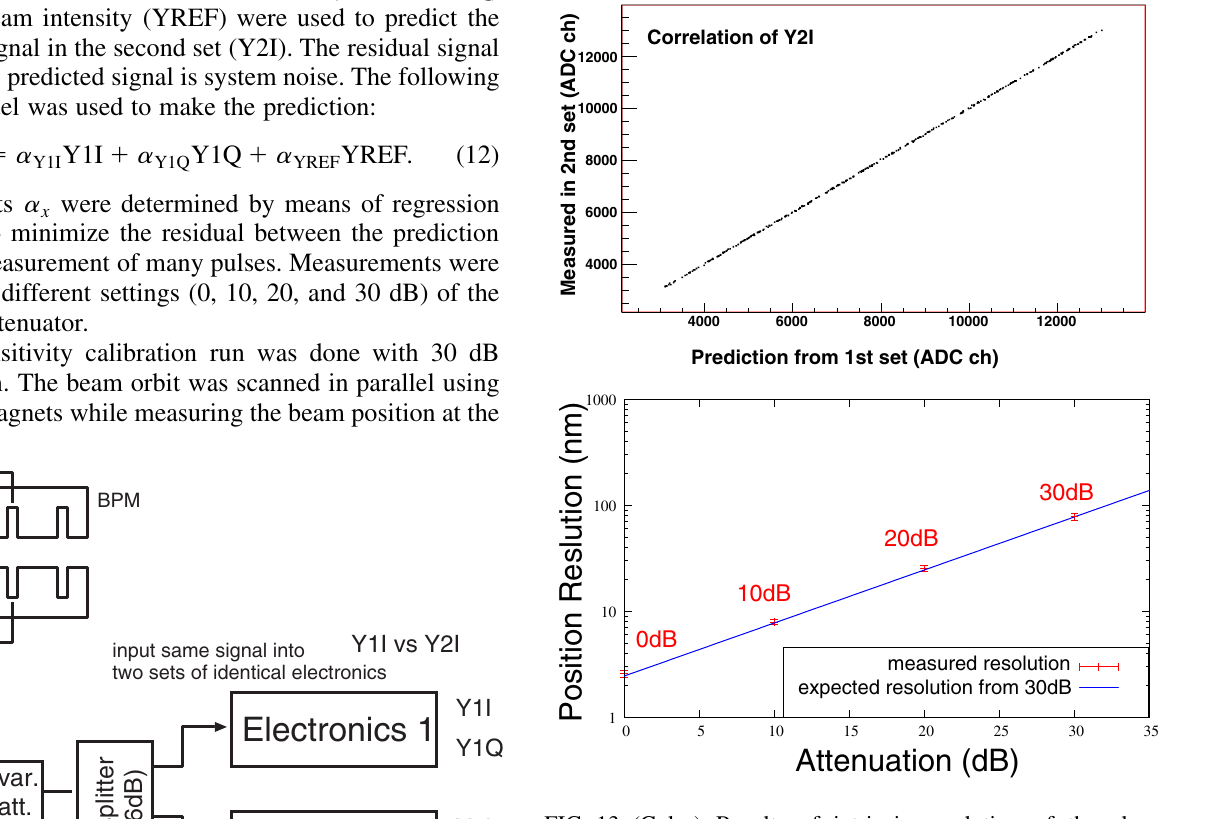
FIG. 13. (Color) Results of intrinsic resolution of the elec- tronics. The scatter plot in the top shows the actual measurement result of Y2I. against the prediction of Y2I from Y1I, Y1Q, and YREF The resolution can be calculated from the distribution of the residual (width of the line). The bottom plot is the summary of various settings of the attenuator. Extrapolation from the data at 30 dB is shown as the line.